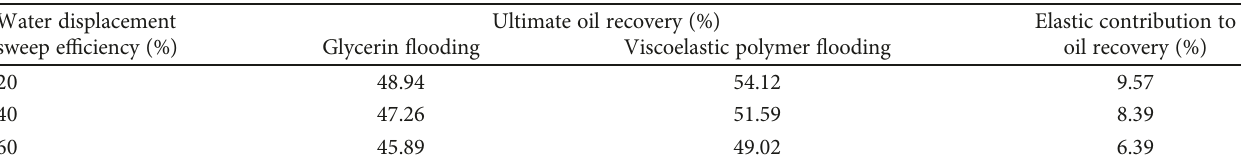
Figure 9: Residual oil distribution of glycerin fl ooding and viscoelastic polymer fl ooding with the same viscosity (40 mPa · s) at a water displacement sweep e ffi ciency of 60% (the dark area is oil, and the lighter the color is, the lower the saturation is; the light area represents the displacing fl uid). Table 2: Displacement e ffi ciency of glycerin and viscoelastic polymer with the same viscosity (40 mPa · s) at di ff erent water displacement sweep e ffi ciency